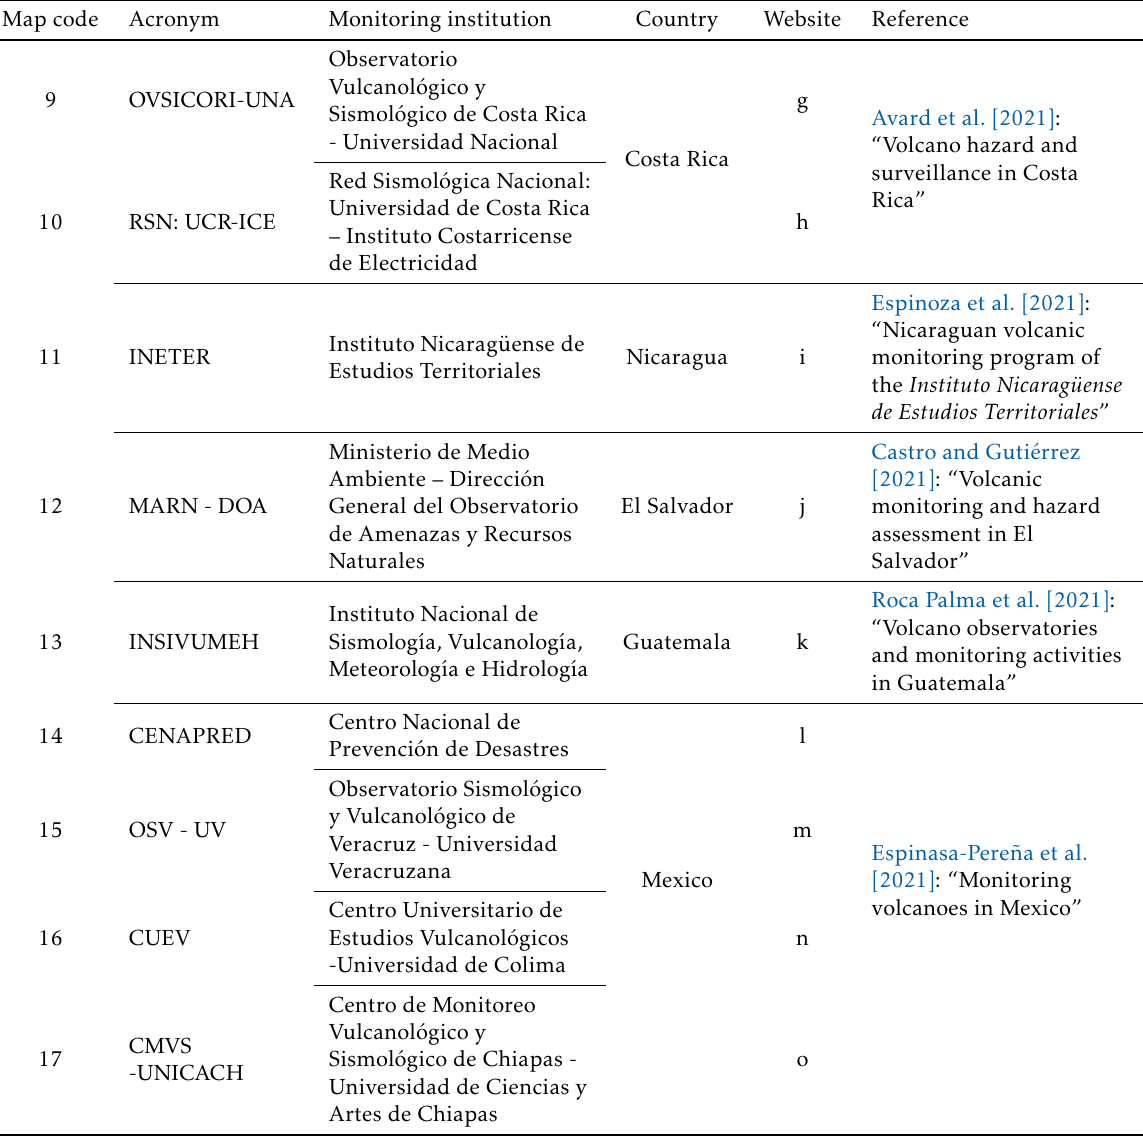
Table 1: [cont.]: Latin American volcano observatories, listed from south to north. Map